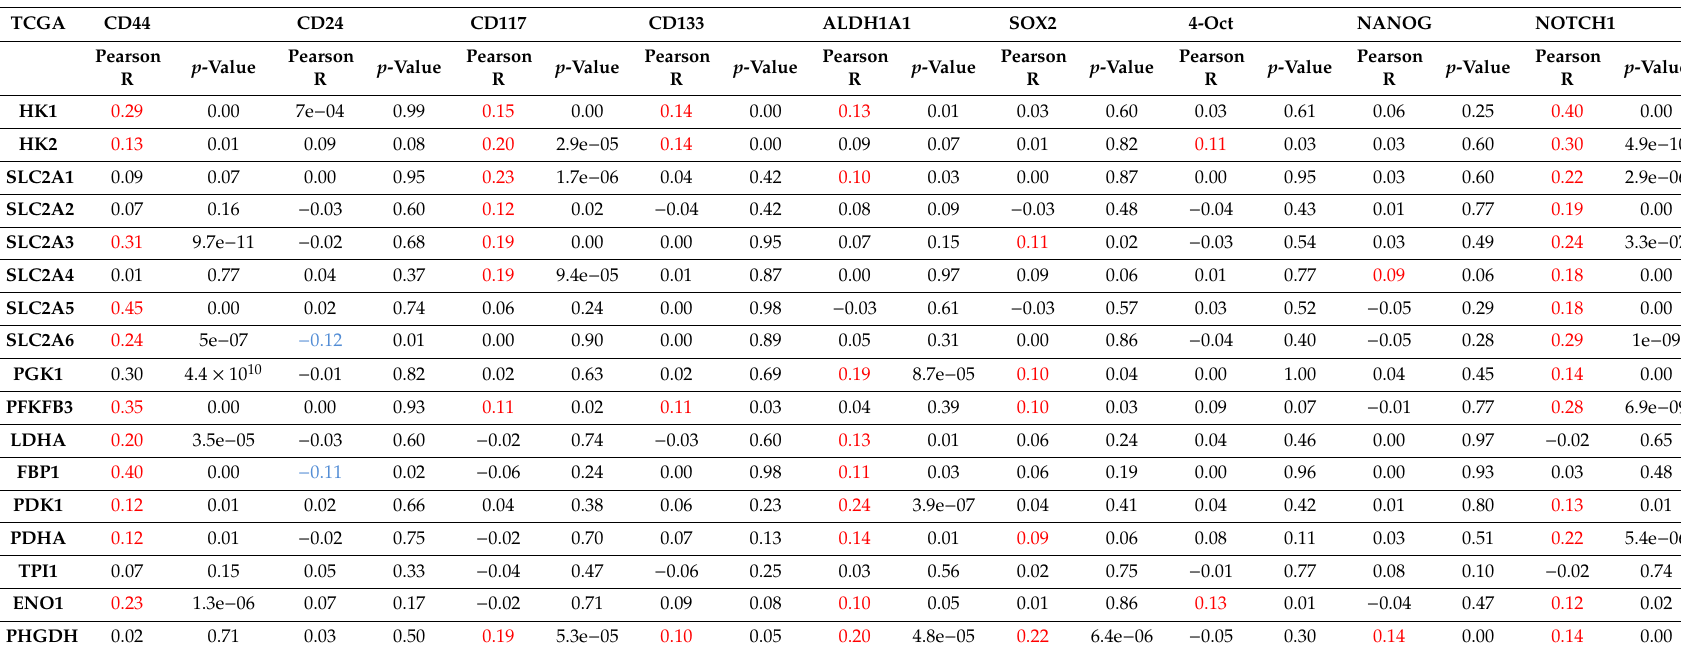
Table 1. Pearson Correlation between the expression of CSC transcripts and the transcripts of glucose transporters and the key enzymes involved in glycolysis in ovarian cancer specimens from TCGA and curated from GEPIA. Red indicates significant positive and blue indicates negative